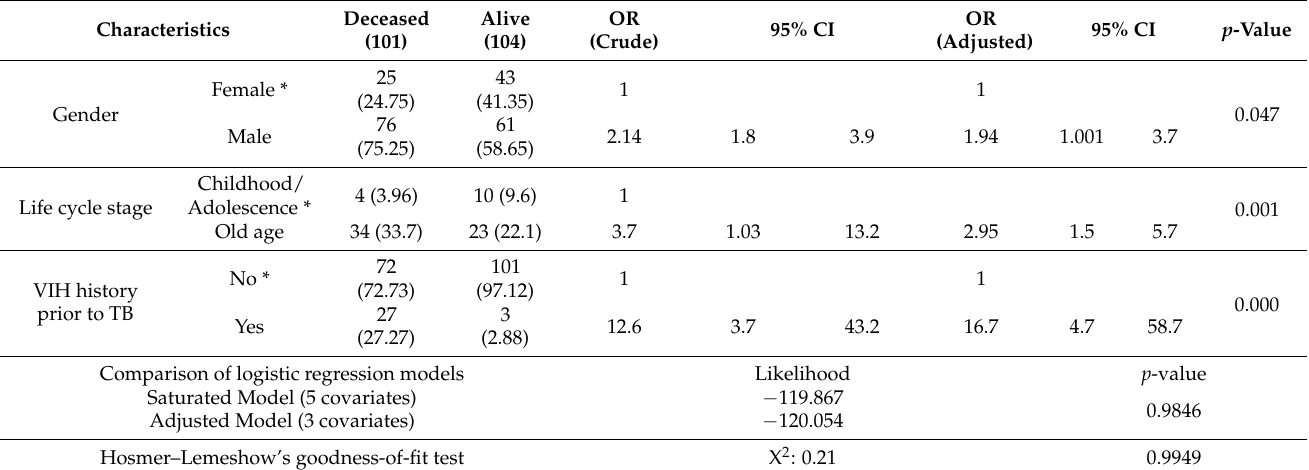
Table 4. Multiple logistic model and associated